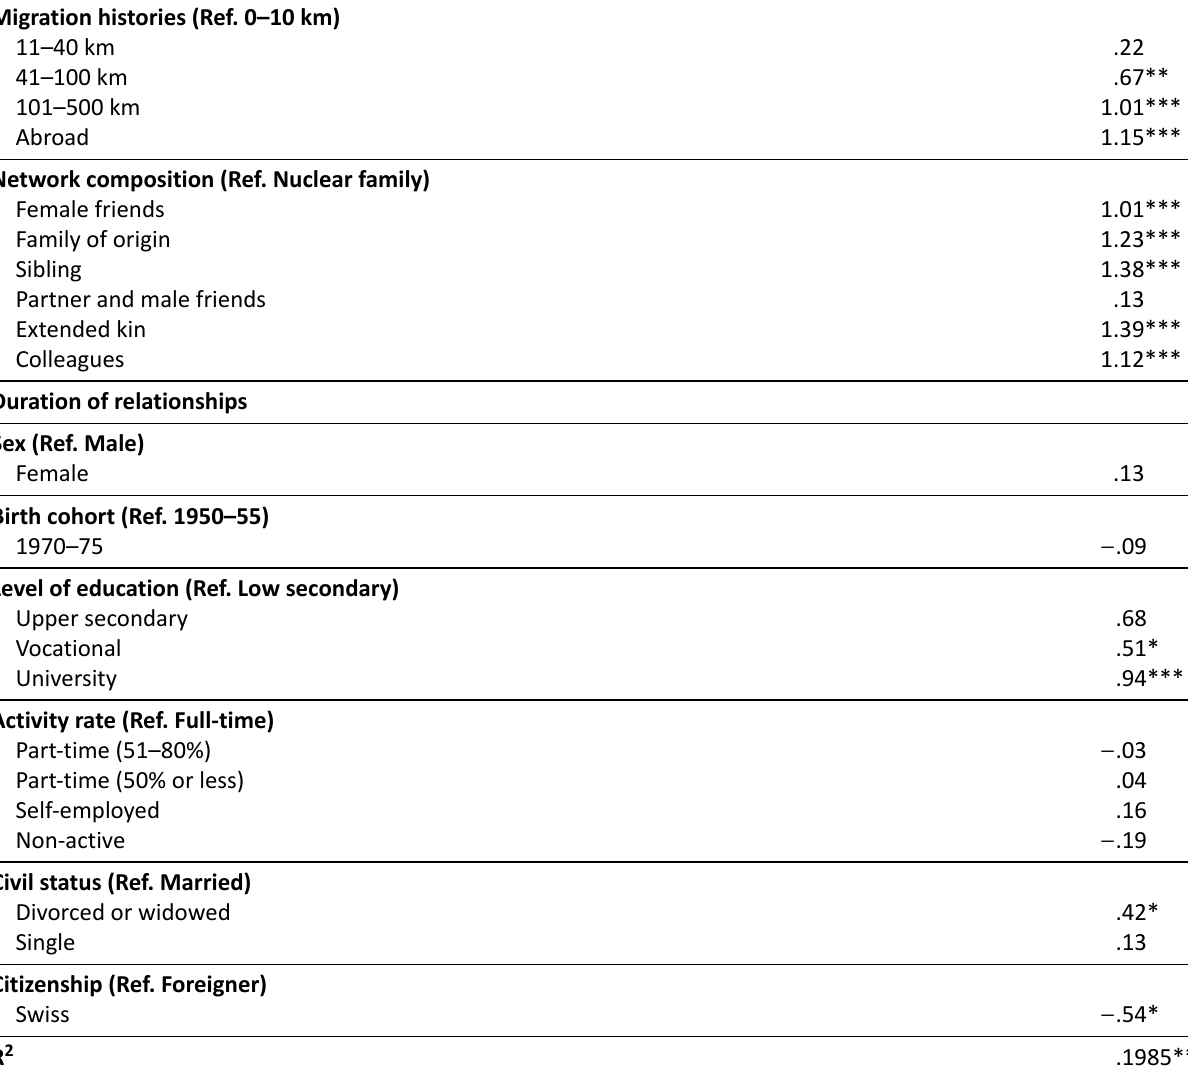
Table 1. Linear regression of the network spatial dispersion (ln km) (beta coefficients). Migration histories (Ref. 0–10